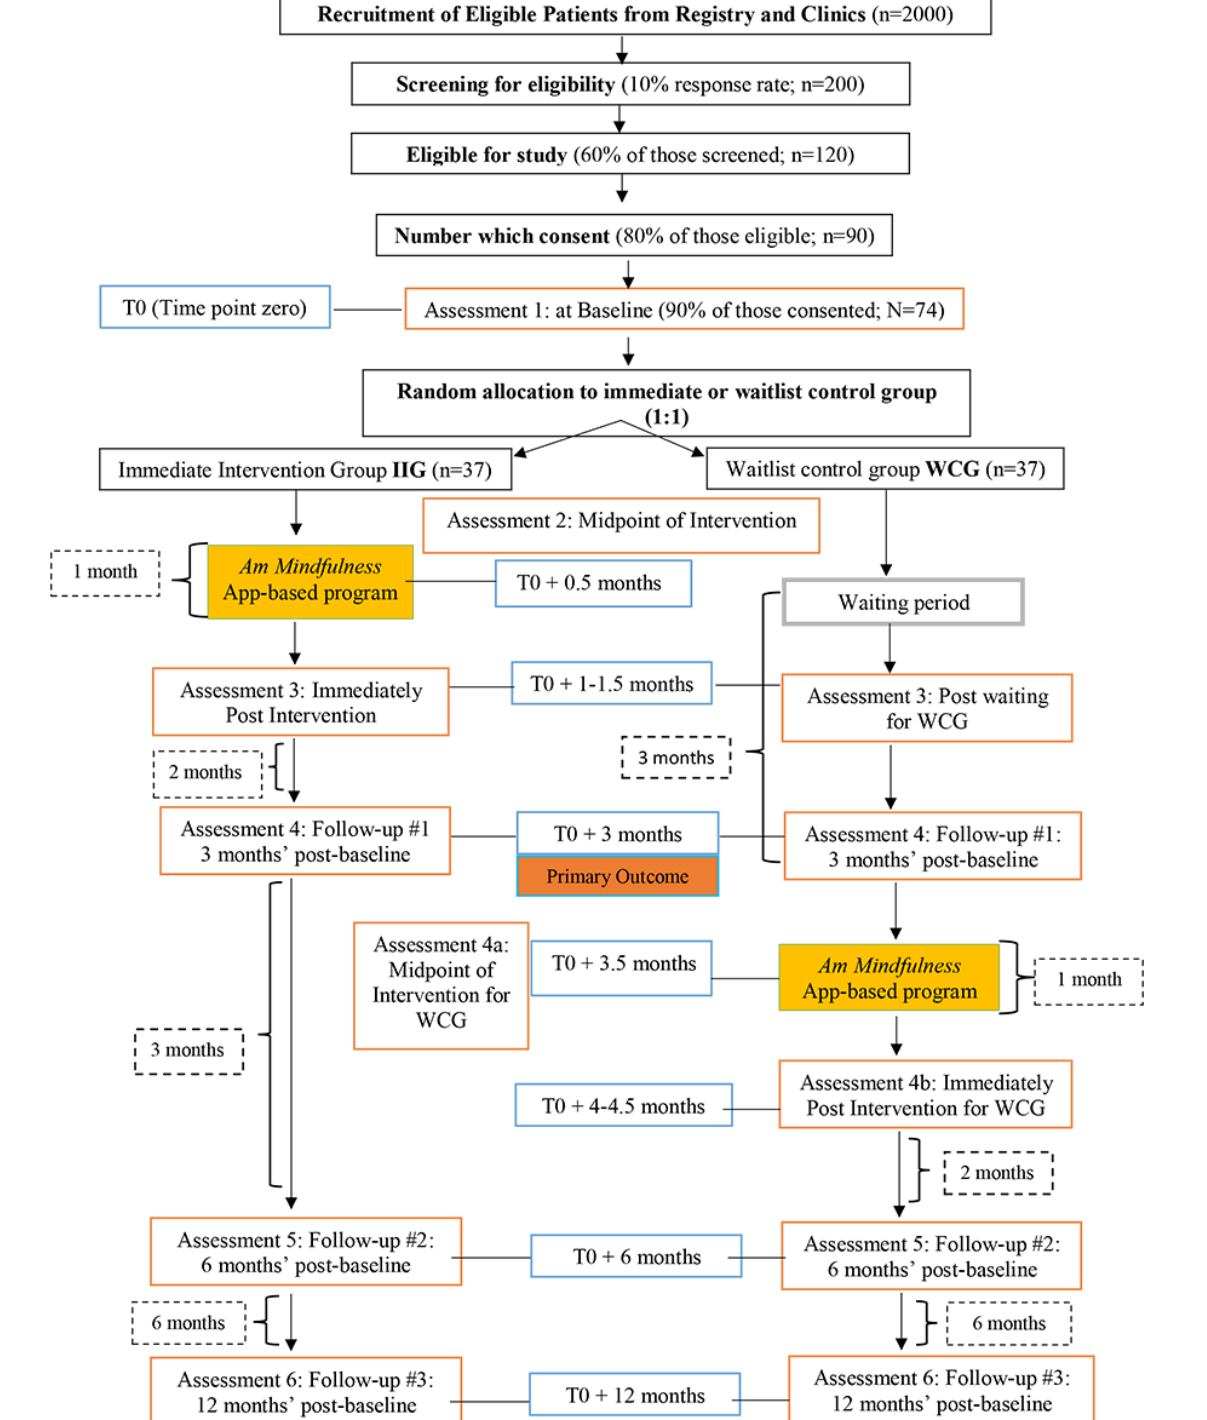
world. Refer to Table 1 for detailed rationale for each inclusion and exclusion